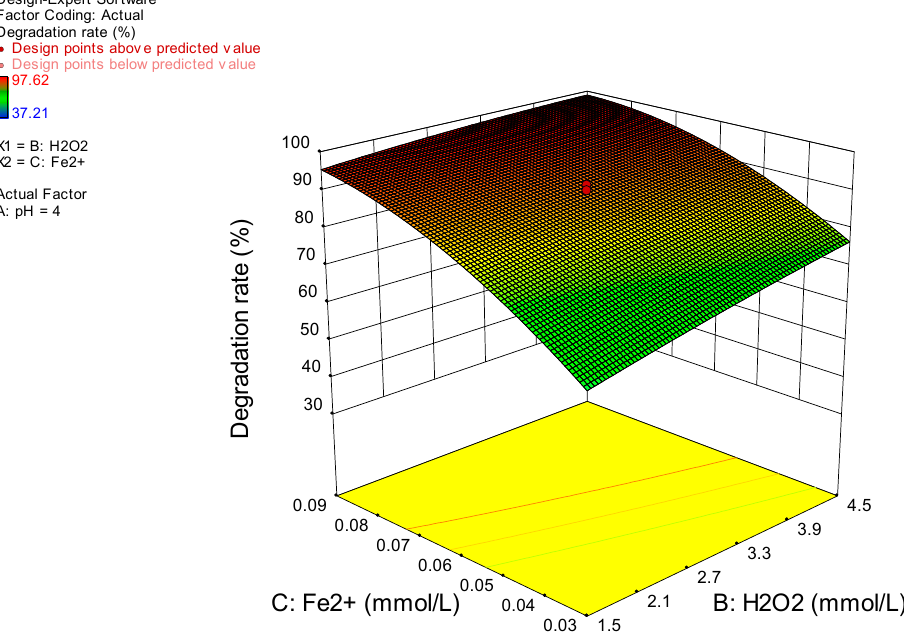
Figure 10. The influence of Fe 2+ and H 2 O 2 concentration on trimethoprim degradation.